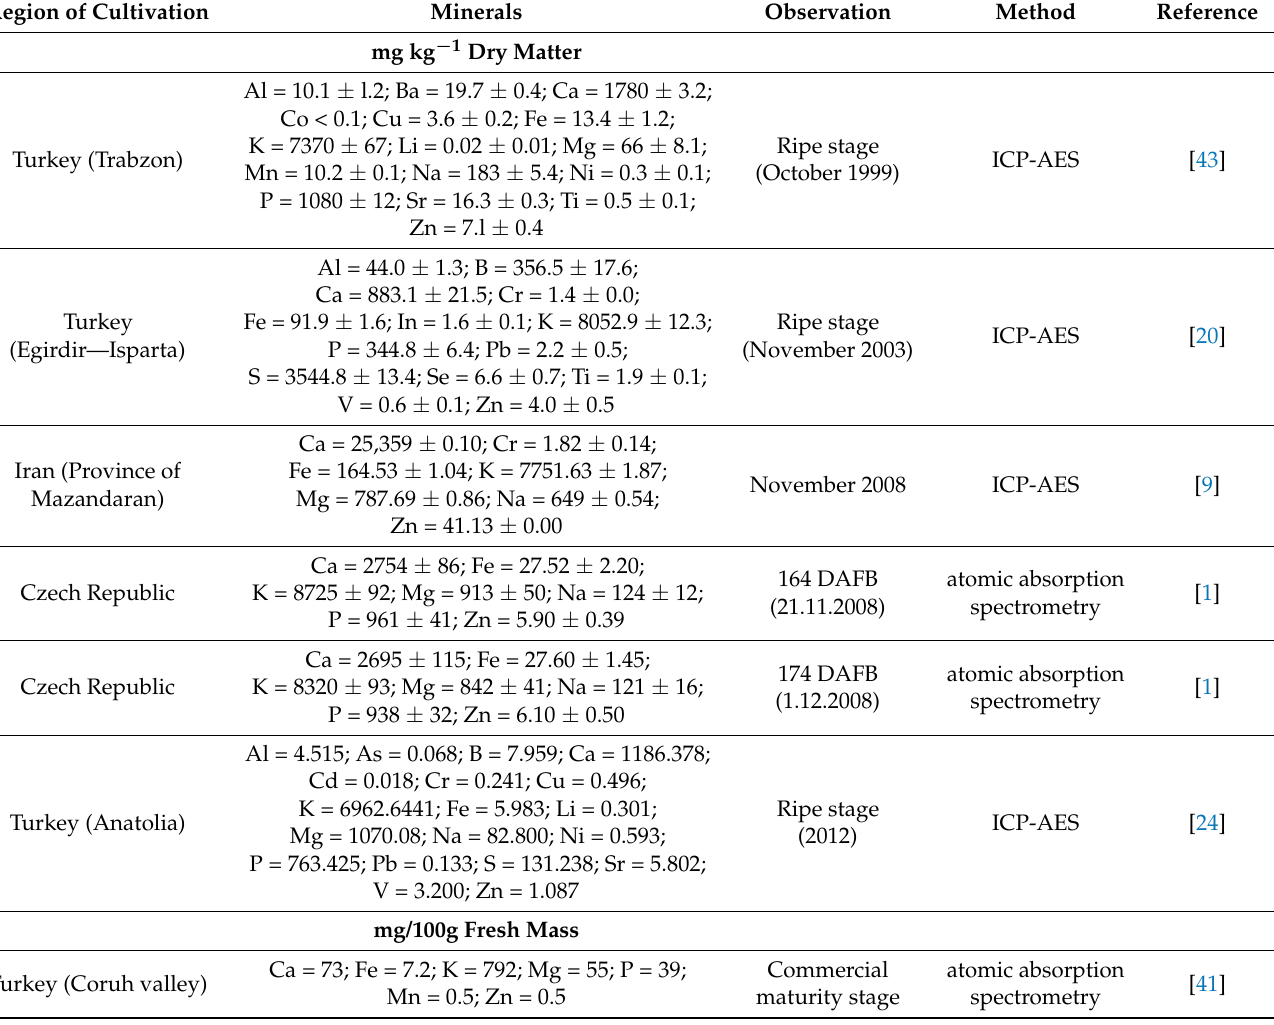
Table 6. Mineral composition of Mespilus germanica